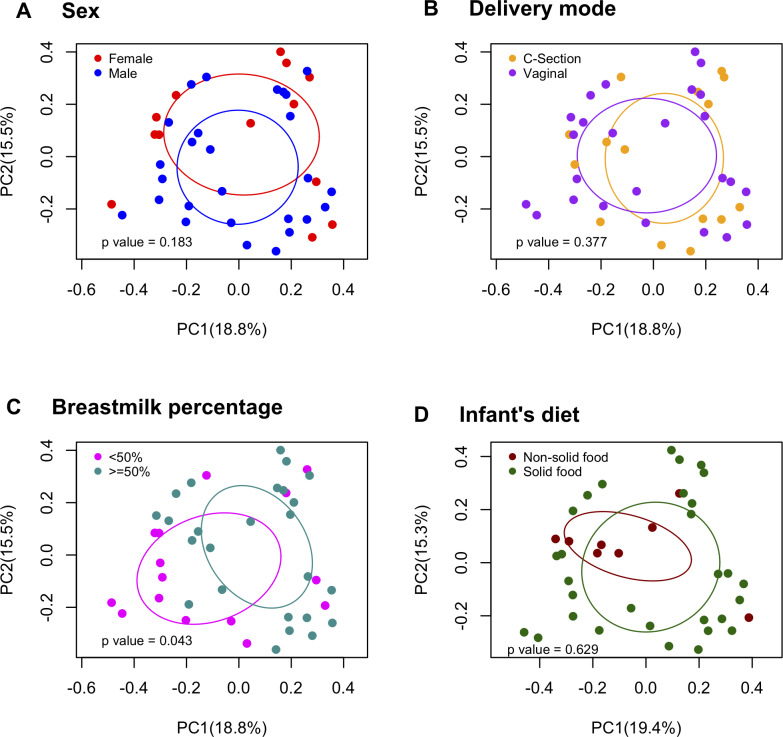
ARG structure by infant covariates.PCoA plots based on all infant (n = 40) samples. Permanova test was calculated to test for differences between groups.